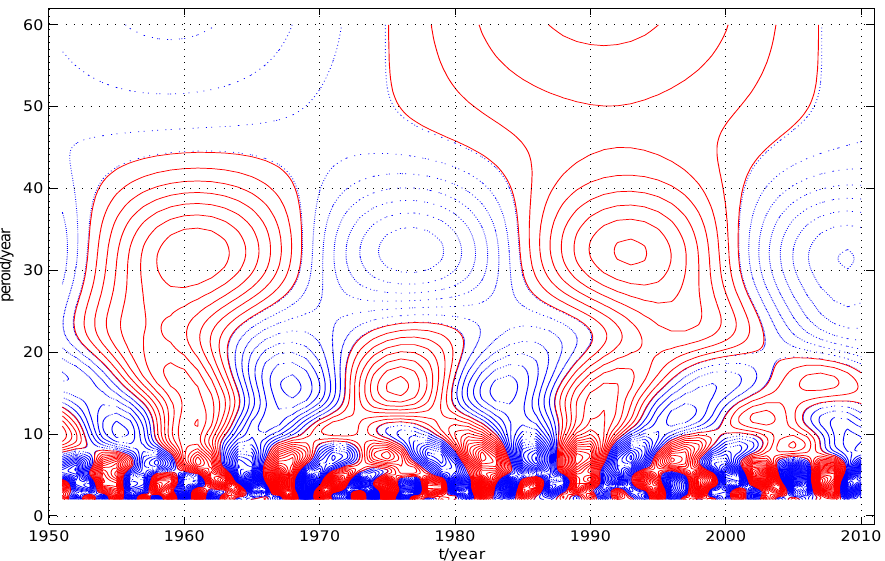
Figure 6. This contour, computed with frequency-domain method of CWT with data preparation method given in previously published papers, namely, M = 2 q , q = min n ∈ Z { 2 n > N } , manifests edge